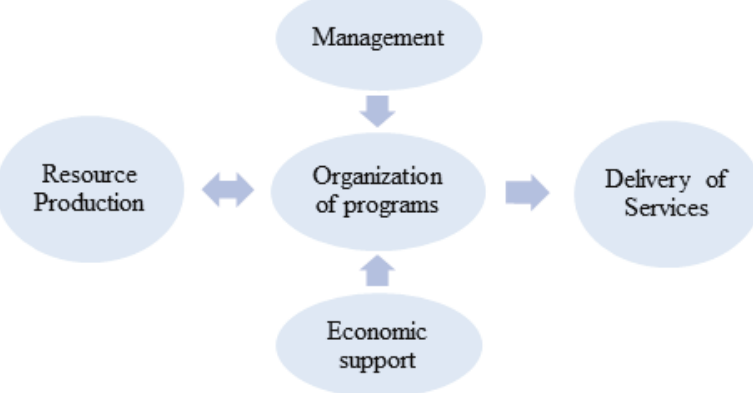
Figure 1: Roemer Model of Health Services